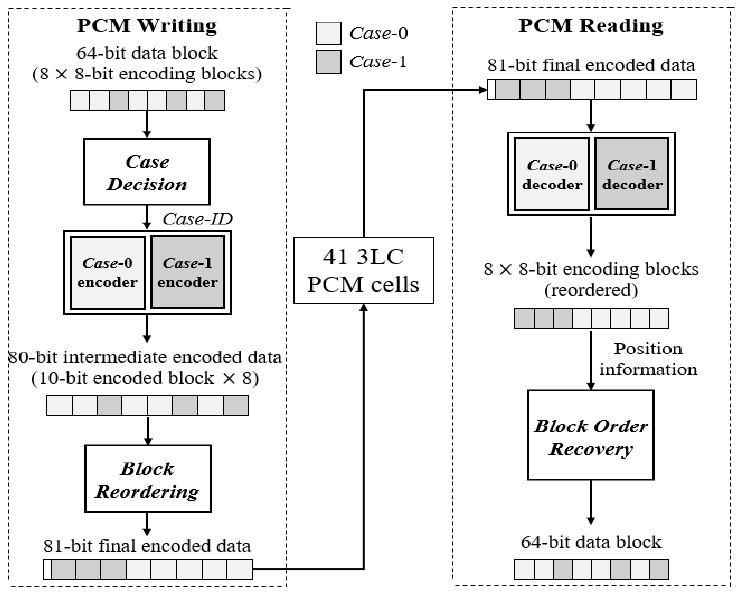
Figure 3. Overall encoding and decoding flow.